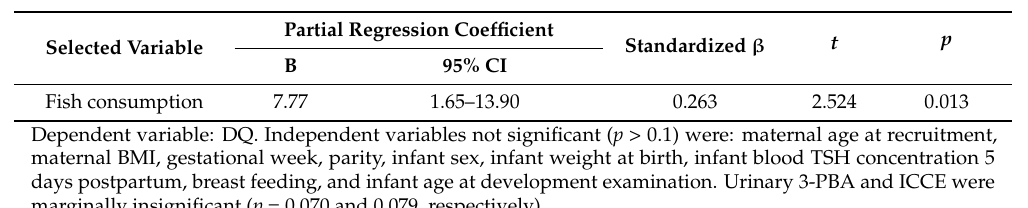
Table 4. Result of stepwise multiple regression analysis (Model 2).